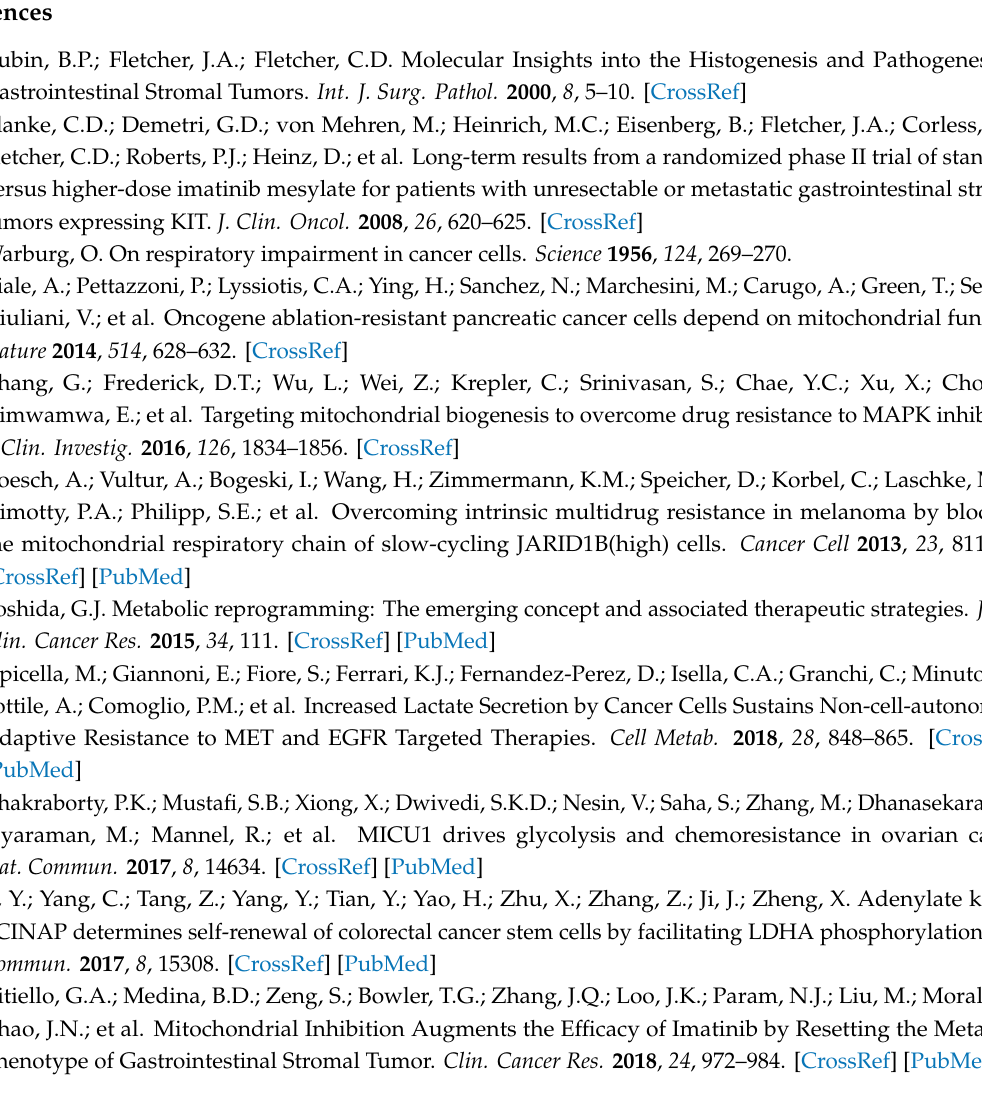
and LDHB in 39 GIST tumors. Imatinib untreated samples are shown at the top and sensitive and resistant imatinib treated samples below. Molecular weight markers (M) are included in all immunoblots and the size markers are given to the right in kiloDalton (kDa). Sample #6-1 was used as a reference for comparison between western blot membranes. Figure S9: Immunoblots corresponding to Figure 7C showing OXPHOS proteins in 39 GIST tumors. Imatinib untreated samples are shown at the top and sensitive and resistant imatinib treated samples below. Molecular weight markers (M) are included in all immunoblots and the size markers are given to the right in kiloDalton (kDa). Sample #6-1 was used as a reference for comparison between western blot membranes. Table S1: Clinical features, mutation status and imatinib treatment for the 35 GIST cases studied. Table S2: Short tandem repeat profiles of the 5 human GIST cell lines in this study. Table S3: Di ff erentially expressed genes for OXPHOS and glycolysis gene sets between Cluster I and